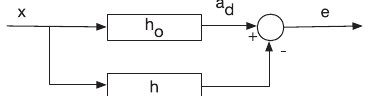
Figure 4. Typical task for fi lter design with x as input signal, h o the desired impulse response function of the fi lter, h the designed fi lter and e the error between desired signal a created by the fi lter h